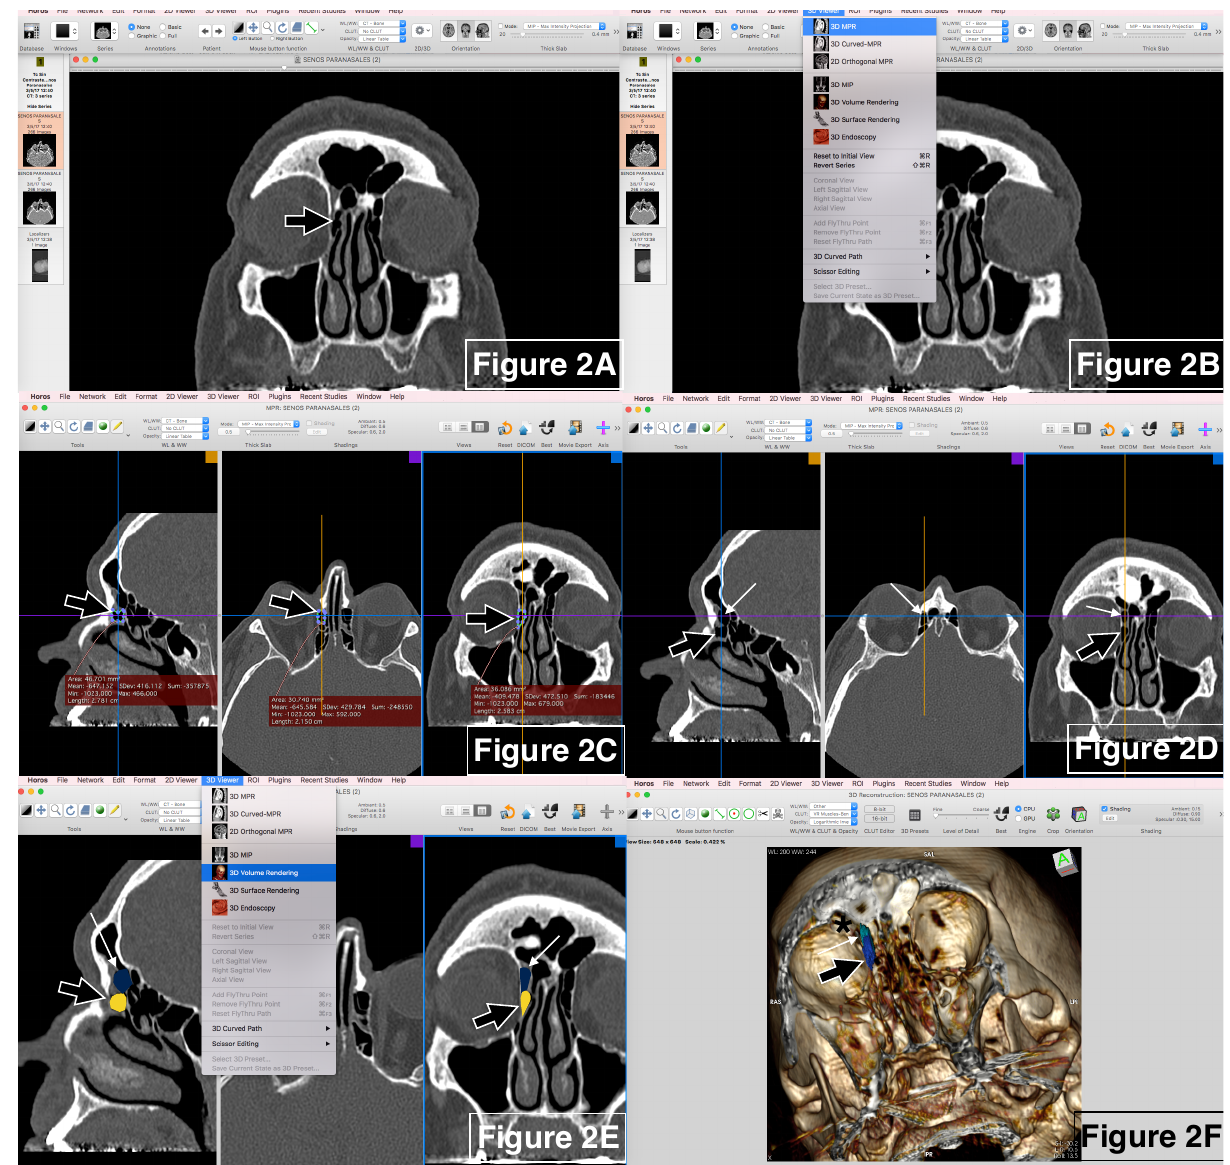
Figure 2. Proposed steps for pre-surgical 3D planning of the AN with Horos®. A) Study selection: Select the largest number DICOM images. B) 3DMPR as a preliminary step to three-dimensional reconstructions using volumetric images and regions of interest (ROIs). C) Location of the Agger Nasi in